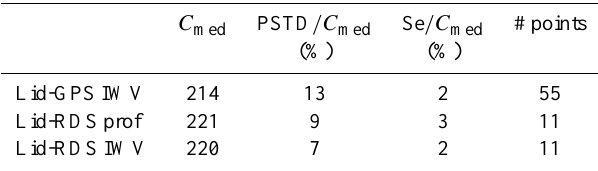
Figure 6. TF 387 / TF 407 determined by 30min of passive daytime observations at approximately 63 ◦ of the solar zenith angles for 2 and 5 April (left and right plot, respectively). Table 5. Principal results (median, pseudo-SD, standard error val- ues and the number of points) for the three calibration methods tested during